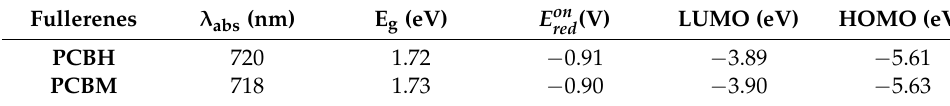
Figure 2. ( a ) UV–Vis absorption spectra of PCBH and PCBM in toluene solution. ( b ) Cyclic voltamme- try waves for fullerene materials (PCBH and PCBM). J - V curves of the ( c ) PCBM- and ( d ) PCBH-based films for electron-only devices. Devices with a structure of ITO/Al/PCBH (or PCBM)/Al were fabri- cated. ( e ) Steady-state PL spectra of different perovskite films. ( f ) Energy levels of the corresponding layers applied in TPSCs. Table 1. Summary data of CV and UV–Vis analysis for PCBH and